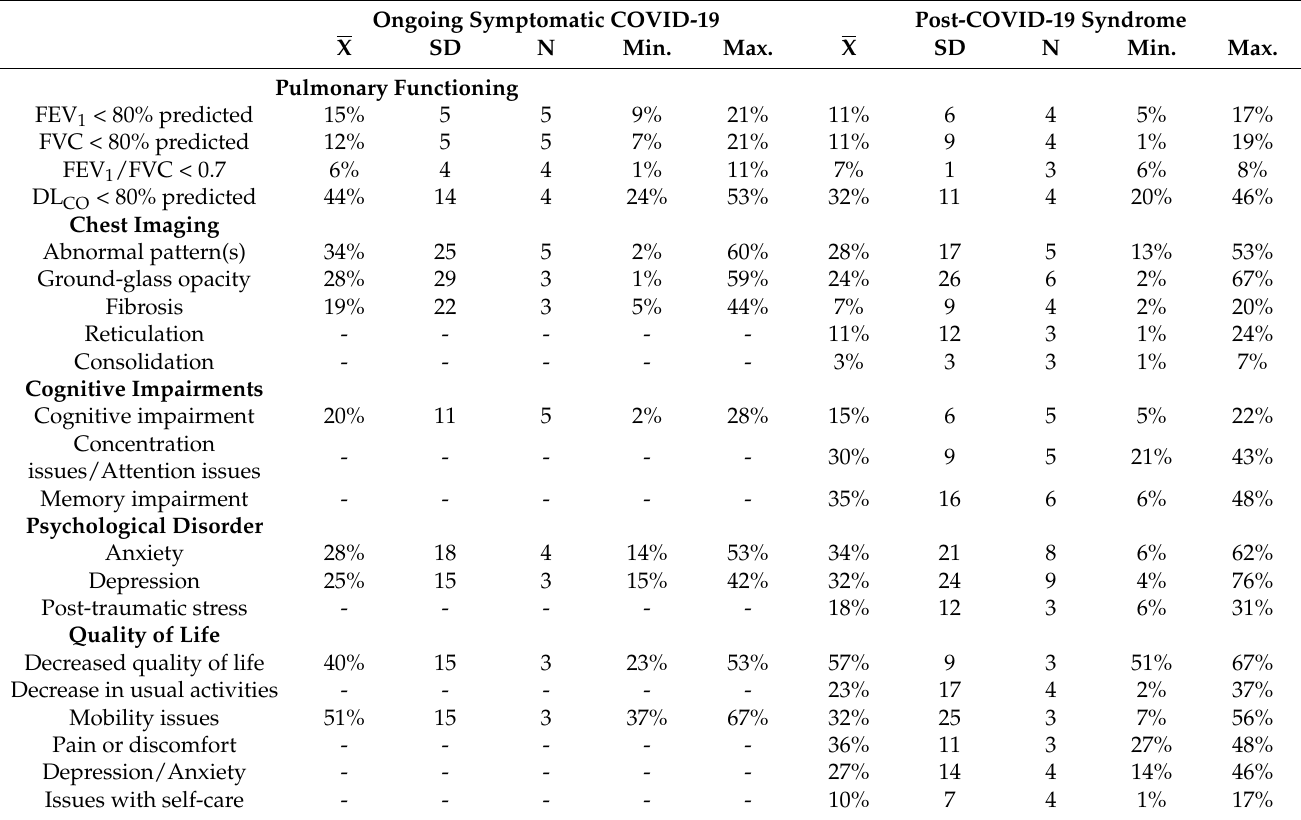
Table 5. Prevalence of Pulmonary and Cognitive Functioning, Psychological Burden, and Quality of Life. Ongoing Symptomatic COVID-19 Post-COVID-19